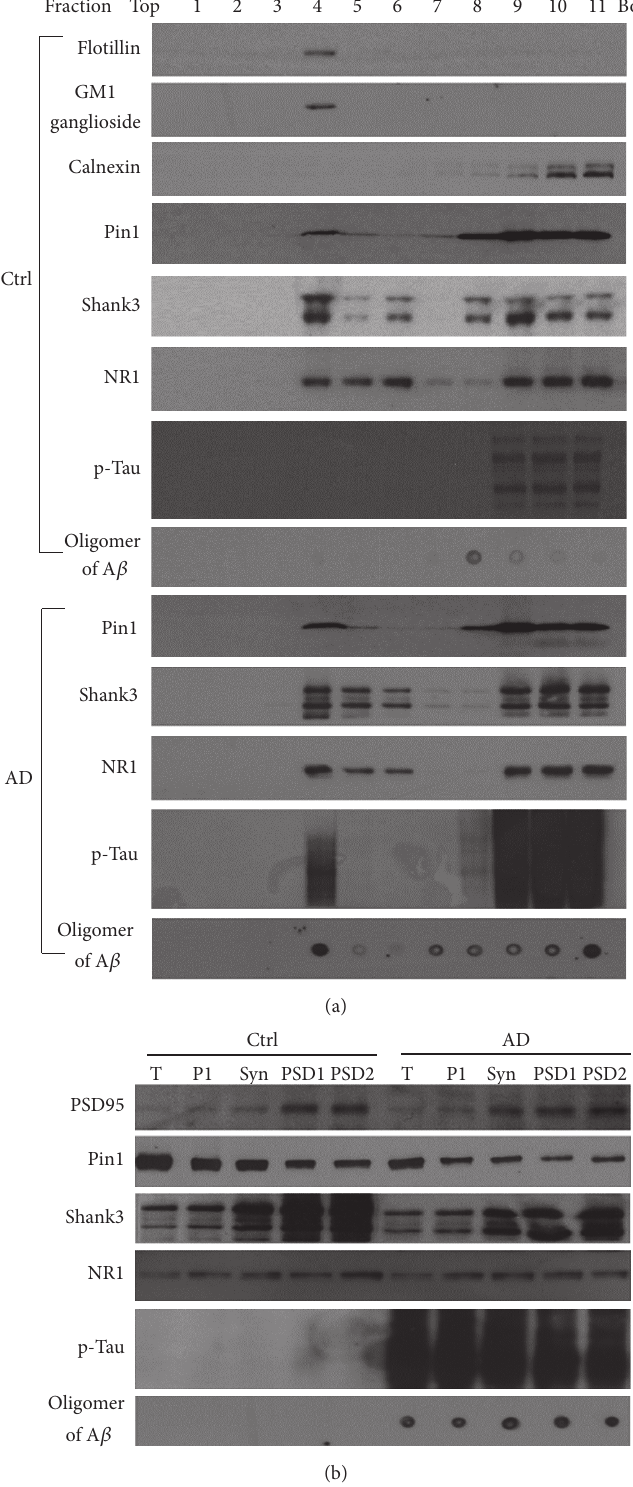
Figure 1: Pin1 proteins exist in detergent-resistant dendritic rafts and PSD fractions coincidently containing phosphorylated Tau, oligomers of A 𝛽 , and glutamate receptor. The detergent-resistant synaptosome suspension was fractionated by sucrose gradient ultracentrifugation to isolate dendritic rafts and PSDs. (a) Analysis of dendritic rafts. Proteins in ultracentrifuged fractions at equal volume were analyzed by Western blot or dot blot. Fraction 4 contained flotillin and GM1 ganglioside, known markers for rafts, along with Pin1, p-Tau, oligomers of A 𝛽 , Shank3, and NR1 proteins. Fraction 4 did not show calnexin, a marker of endoplasmic reticulum (ER). (b) Analysis of the PSD. PSD proteins at equal amounts were analyzed by Western blot or dot blot. PSD95 and Shank3, both known protein markers of the PSD, were enriched in the PSD fraction (PSD2), along with Pin1, NR1, p-Tau, and oligomers of A 𝛽 . Ctrl: human control tissues; AD: human AD tissues; T: total tissue; P1: total membrane; NR1: a subunit of NMDA receptor; Syn: synaptosome; PSD1: pellets from the synaptosome treated once by 0.5% Triton X-100; PSD2: pellets from PSD1 treated once more by 0.5% Triton